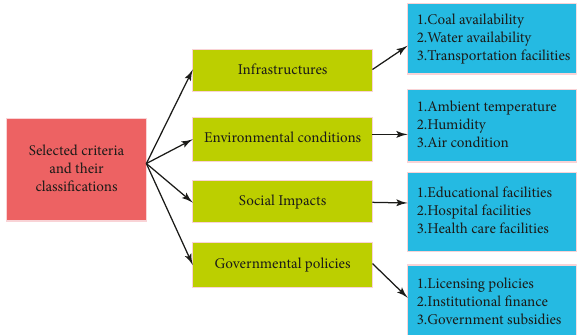
Figure 3: Criteria representation in the selected 3-polar